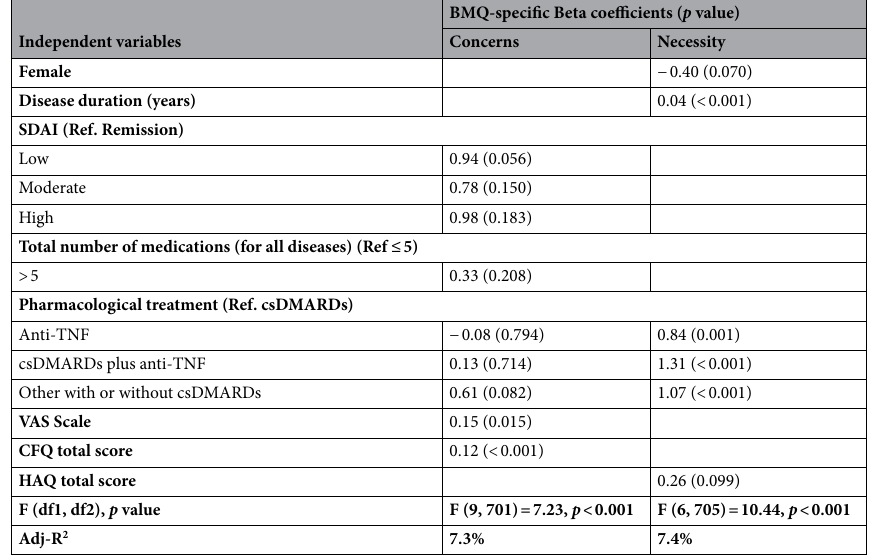
Table 4. Multivariate linear regression models for BMQ-Specific dimensions: Beta coefficients ( p value) (n = 712) [Only variables significant at p < 0.10 in the within-block regression models entered the multivariate final